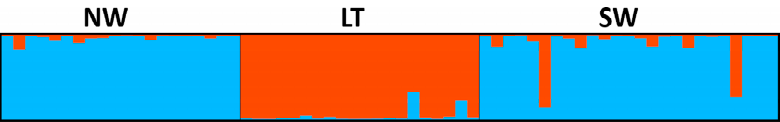
Figure 3. Bayesian estimation of the genetic structure of the sampled regions. Maximum support for K = 2 (DeltaK = 96.6) assuming admixture, correlated alleles and no local priors. LT, SW and NW—sampled populations from the Littoral, South-West and North-West Regions, respectively.